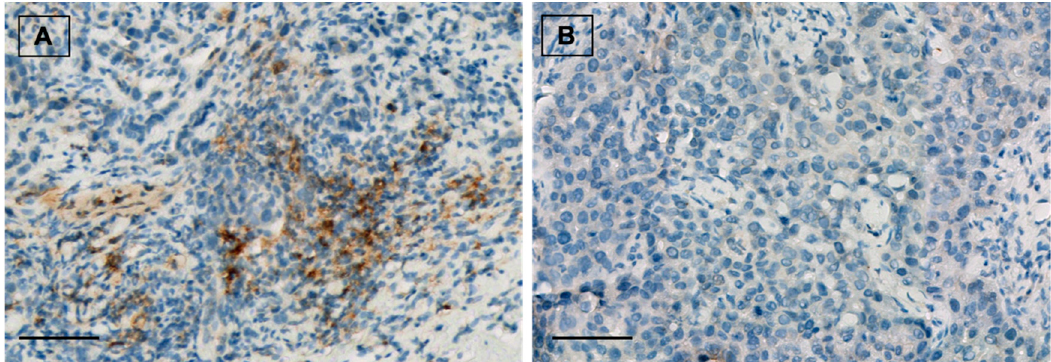
Figure 2. ( A ) PD-L1 positive staining in breast carcinoma. Immunohistochemical staining for PD-L1 (brown) with Mayer’s hematoxylin counterstain. ×20, scale bar = 100 µm. ( B ) PD-L1 negative control. ×20, scale bar = 100 µm .